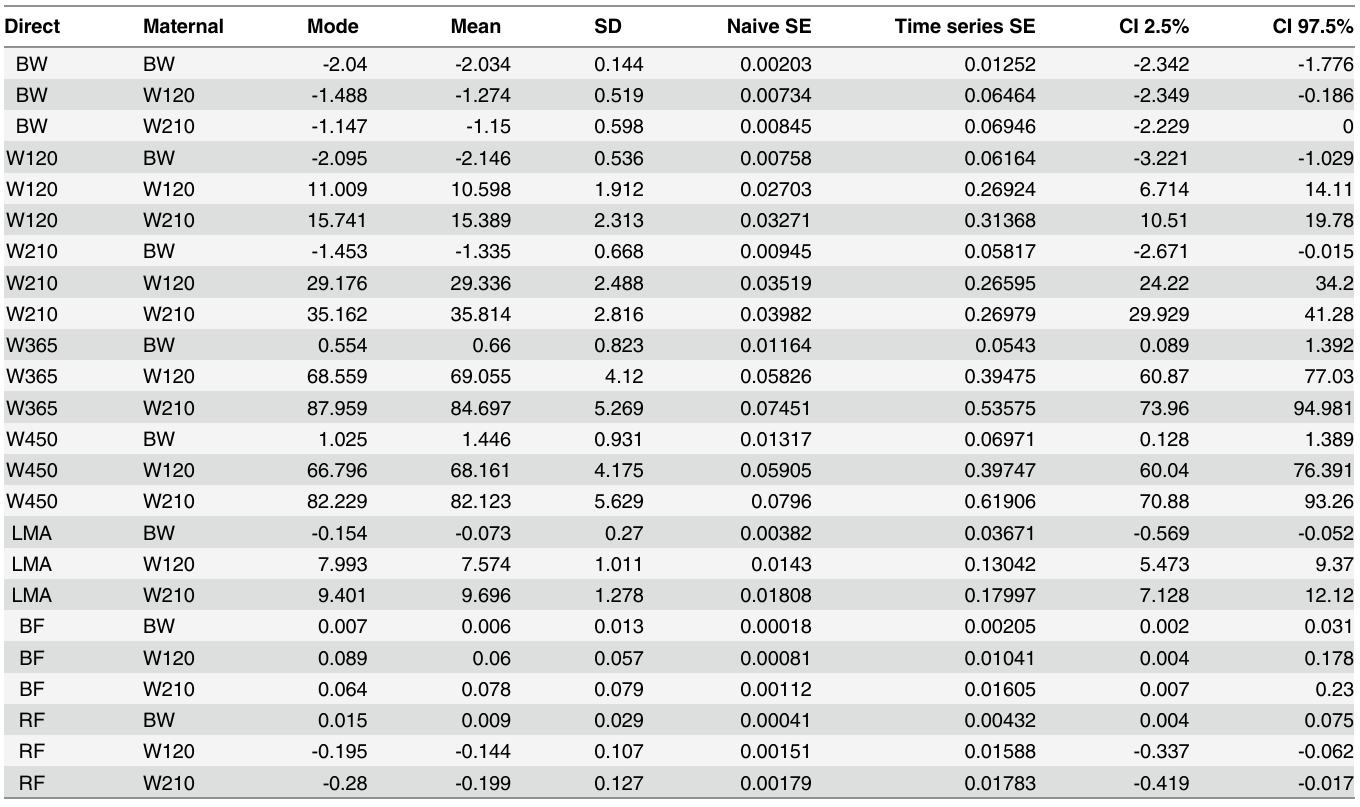
Table 4. Marginal posterior distributions of the covariances among genetic additive direct and maternal effects among growth and carcass traits in Polled Nellore cattle.